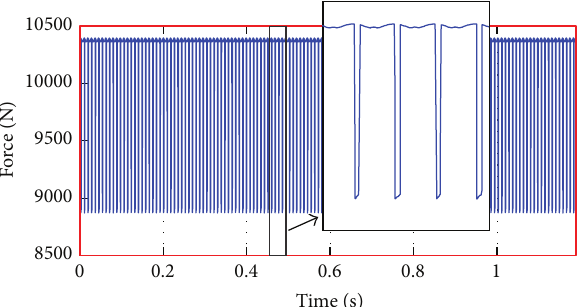
Figure 10: Bearing time domain force profile plot for outer race defect in vertical direction.